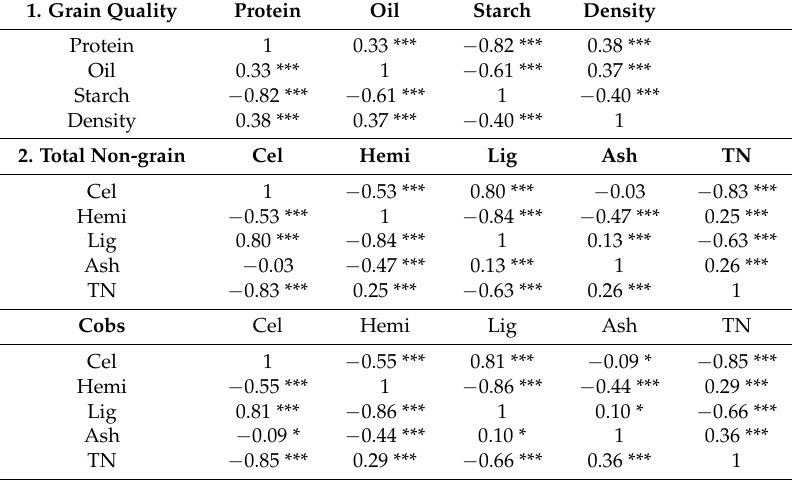
Table 2. Pearson correlation coefficients for protein, oil, and starch concentration and grain density, (grain quality), cellulose (cel), hemicellulose (hemi), lignin (lig), ash, and total nitrogen (TN) concentrations (total non-grain, cobs, husks, leaves, and stems), of temperate and tropical maize during 2014 and 2015 growing seasons in Boone,